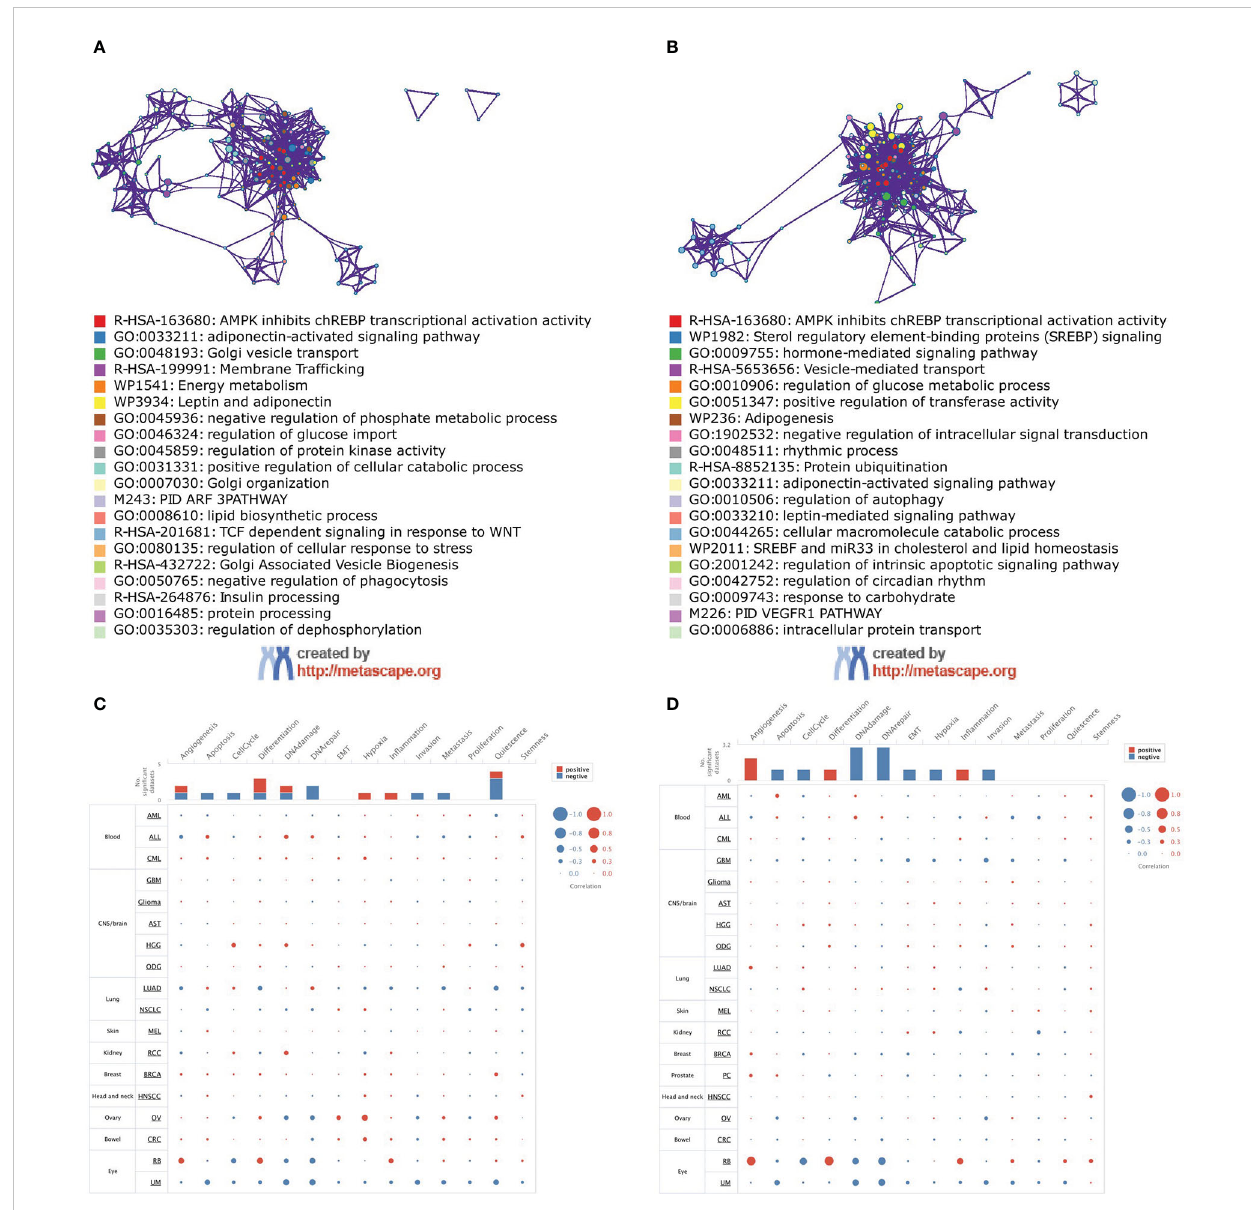
FIGURE 8 Function analysis of ADIPOR1 and ADIPOR2. (A, B) The function enrichment analysis of ADIPOR1/2 using MetaScape database. (C, D) The function analysis of ADIPOR1/2 using CancerSEA